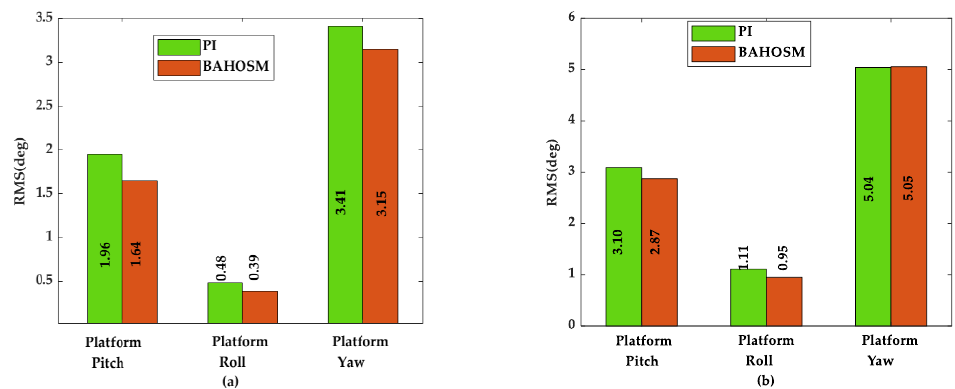
Figure 8. RMS of the platform motion in case 1 ( a ) and case 2 ( b ).